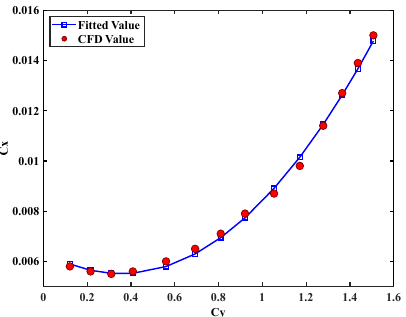
Figure 5. Lift drag coefficient of NACA23012 airfoil.